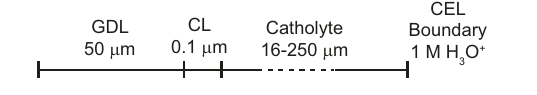
Fig. 6 The schematic of 1D COMSOL modelling. GDL and CL refer to gas diffusion layer and catalyst layer,